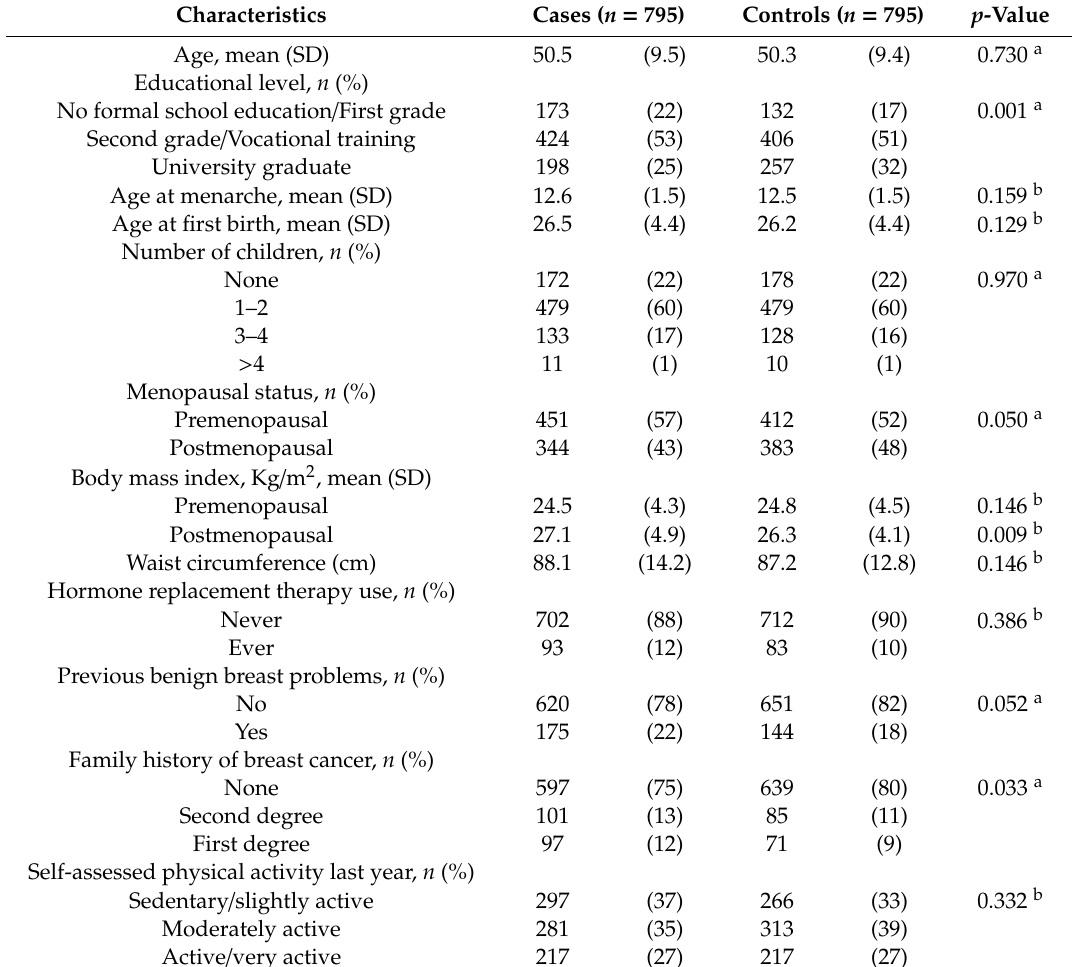
Table 1. Baseline characteristics among breast cancer cases and